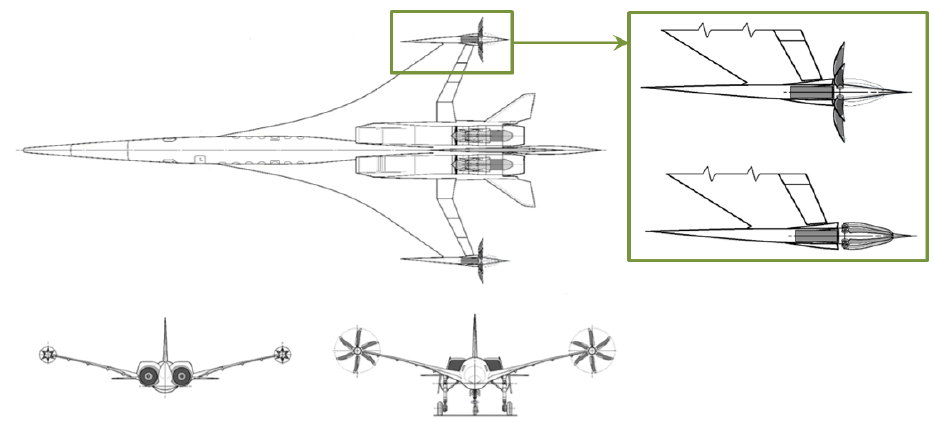
Figure 4. A scheme of notional supersonic aircraft with two cruise engines and two turboprop engines in pusher configuration.